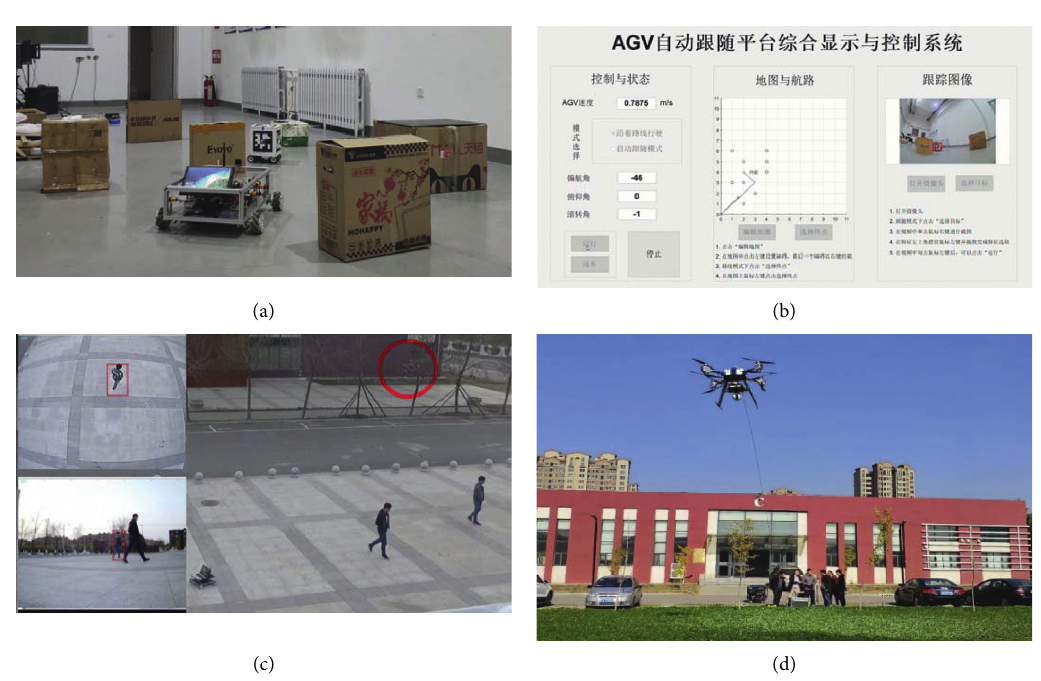
Figure 6: Preliminary indoor/outdoor experiments. (a) Pursuit-evasion experiment between two UGVs in 2D indoor environment. (b) Real-time status of ground station. (c) Collaborative tracking experiment of UAV/UGV heterogeneous system in 3D outdoor en- vironment. (d) Heterogeneous system consisting of tethered UAV and